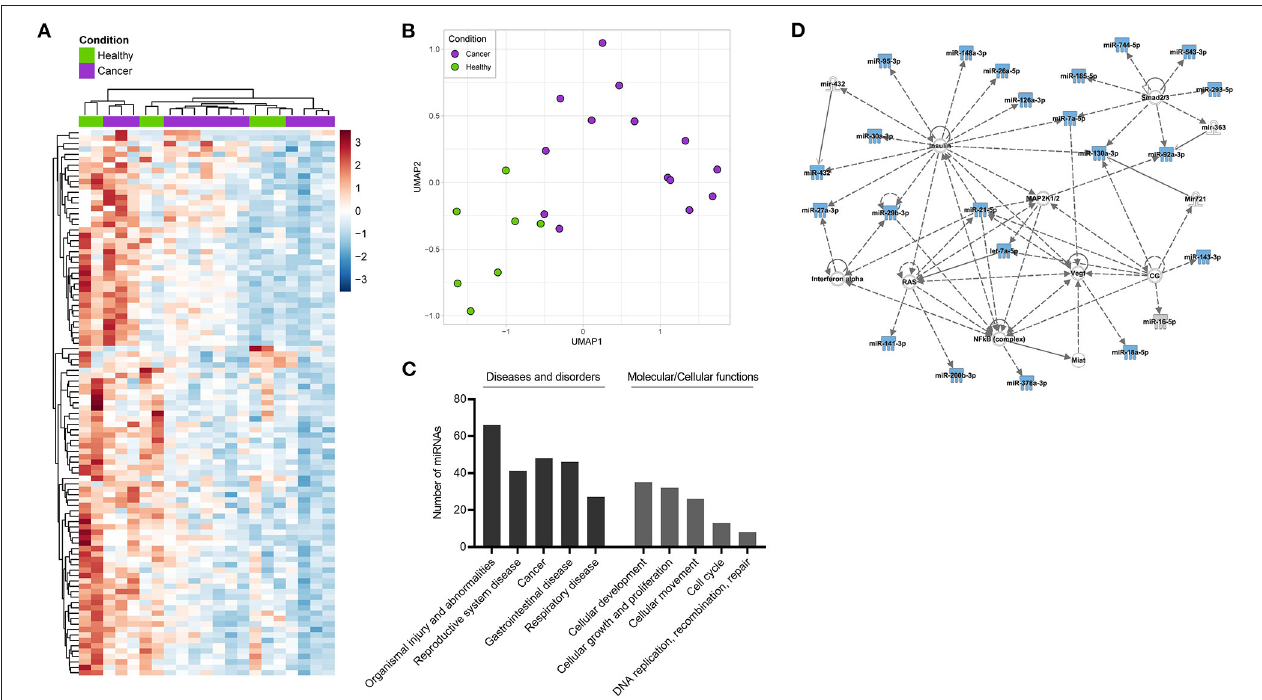
FIGURE 6 | Clustering and pathway analysis of miRNAs from saliva-derived exosomes. (A) Unsupervised hierarchical clustering heatmap and (B) Uniform manifold approximation and projection (UMAP) visualizations of saliva-derived miRNAs which were HD- or HNSCC-exclusive or overlapped with significant difference between the two groups (total of 101 miRNAs). (C,D) Ingenuity pathway analysis (IPA) of the same miRNAs. (C) Shows diseases and biological functions most significantly associated with the identified miRNAs. Categories within a group are shown in increasing order of p -value. (D) Shows the highest ranked network to which identified miRNAs (blue symbols) contribute. Solid lines indicate direct interaction, dashed lines indicate indirect